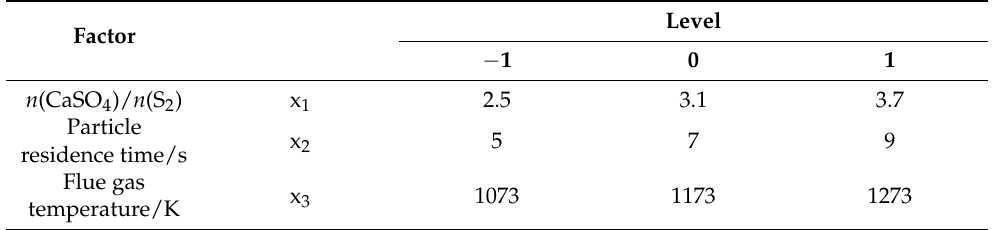
Table 5. Experimental factors and levels.